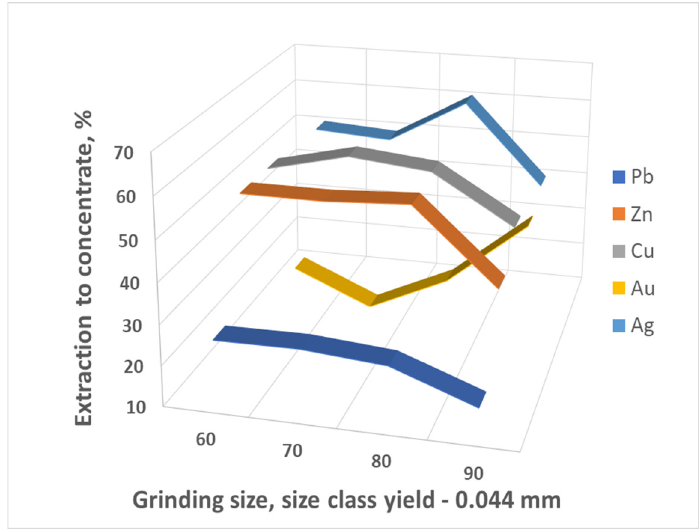
Figure 2. Dependence of the recovery of valuable components on the grinding size.